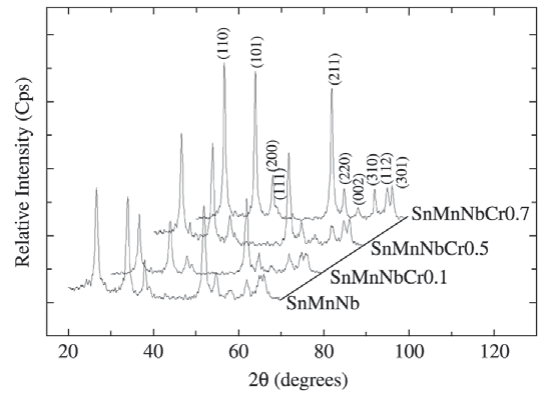
Figure 1. X-ray diffraction patterns of powders prepared by Pechini method, calcined at 500 °C for 15 h.